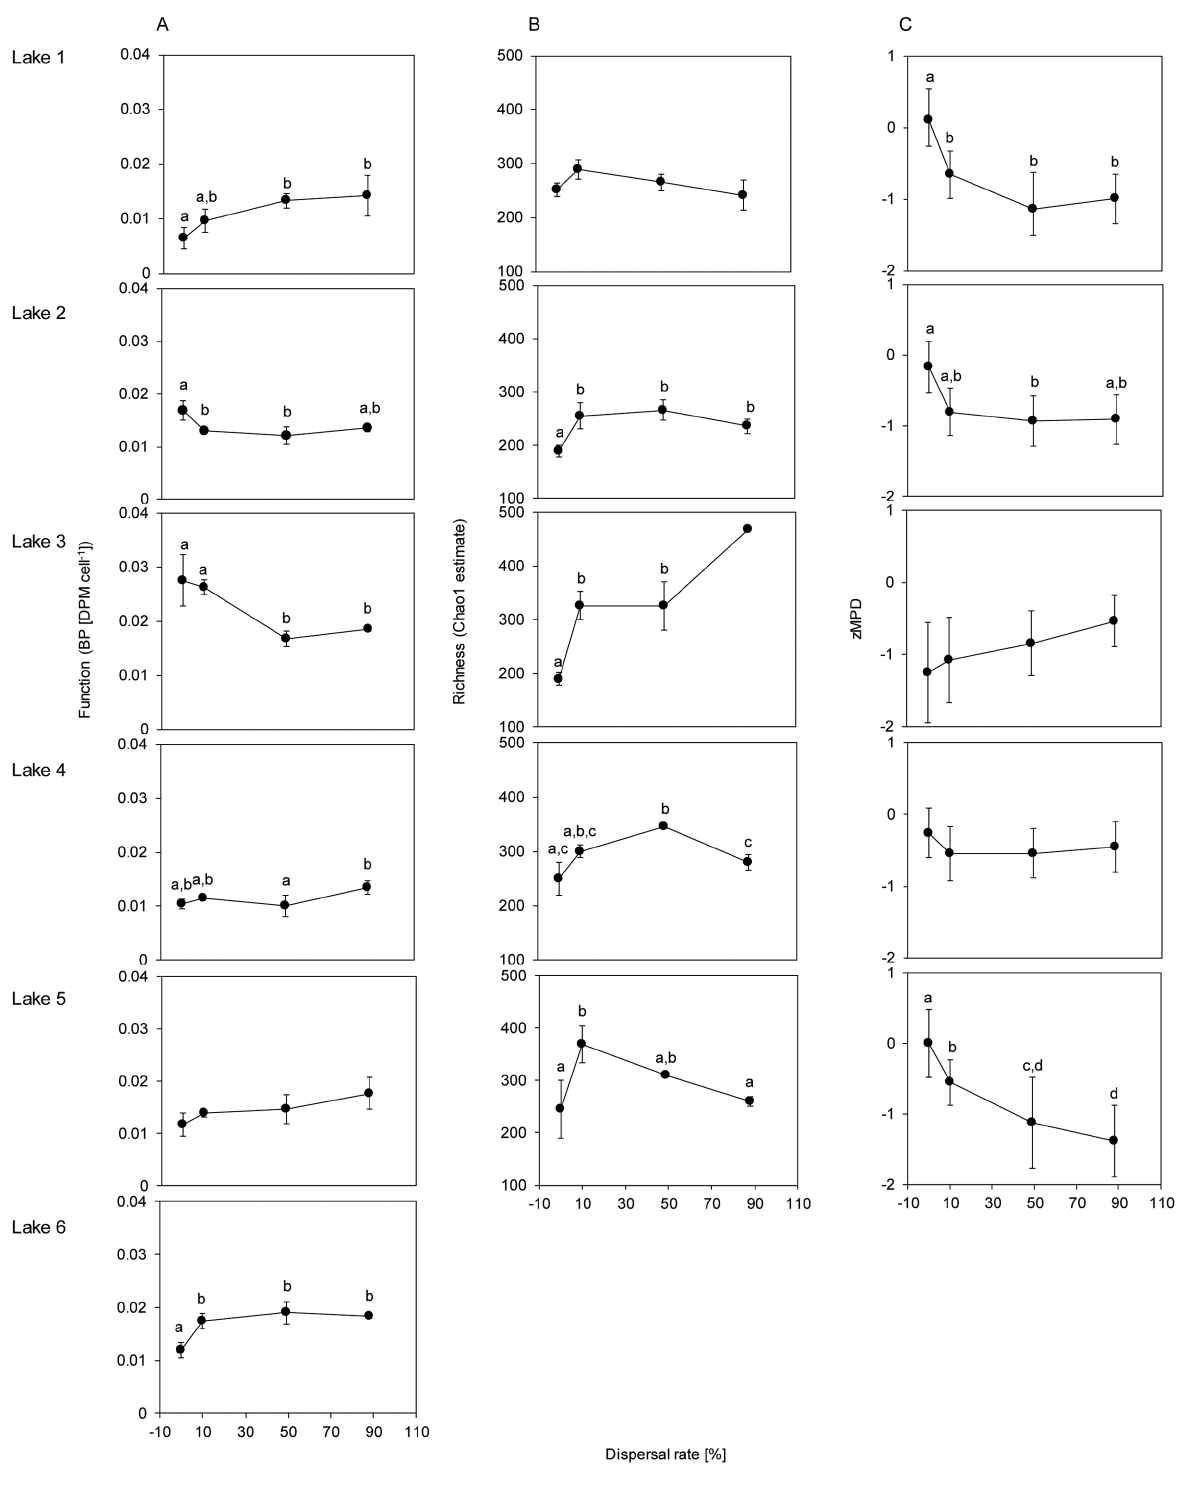
Figure 1. The influence of dispersal on community functioning (A), taxonomic (B) and phylogenetic diversity (C). Community functioning is assessed as per cell bacterial production (A), local richness of the bacterial community estimated by Chao1 (B), and average phylogenetic distance between bacteria in a community estimated as standardized effect size of MPD (C) for each lake (1–6) in relation to dispersal rate (I–IV). Error bars are standard errors of within treatment replicates in (A and B), and standard deviations calculated from 100 single trees in (C). No replicates were available for dispersal rate IV in lake 3 in (B). Lake 6 is missing in (B) and (C) because DNA could be extracted from dispersal rate I only. Bars with different letters denote significant differences between dispersal treatments within one lake, assessed form Tukey’s post-hoc test in one- way ANOVAs.